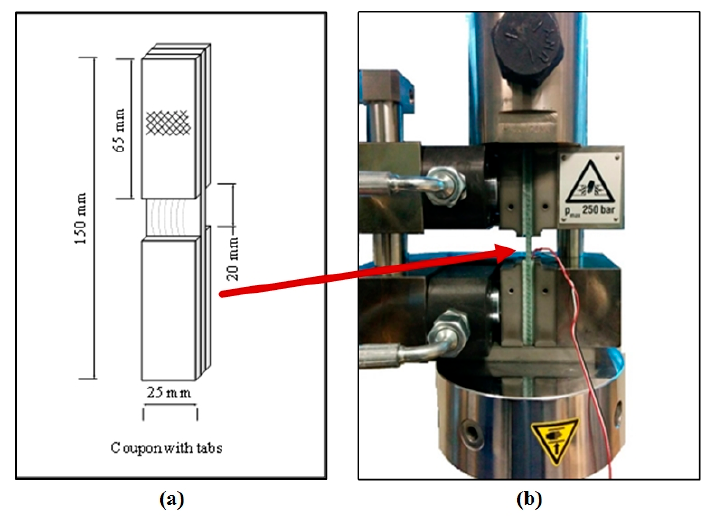
Figure 2. ( a ) Schematic of a typical compression test specimen, and ( b ) the actual HCCF set up with sample.